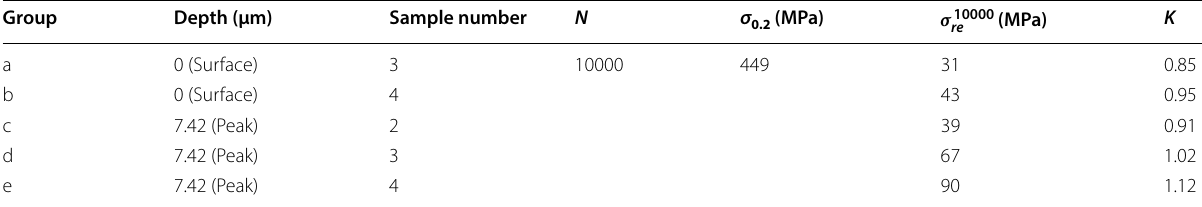
Table 8 Residual stress relaxation